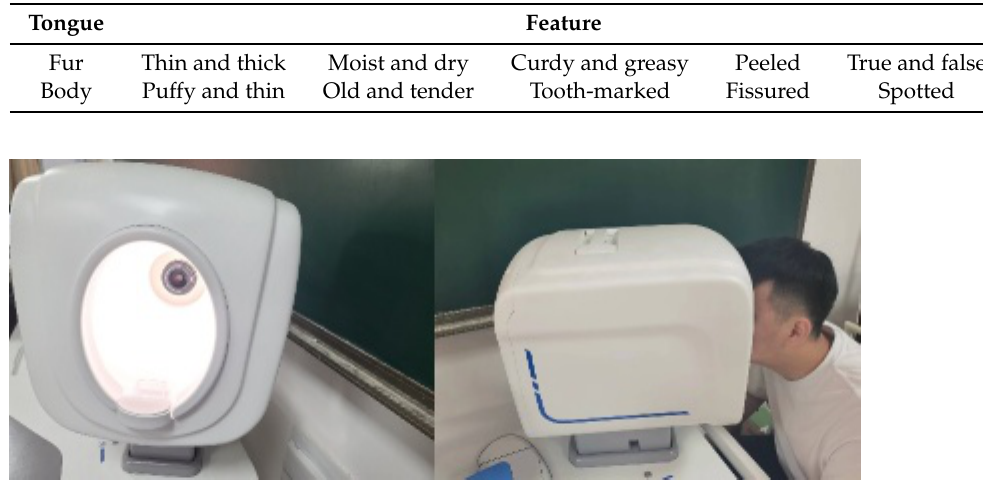
Table 2. The tongue fur and body features.